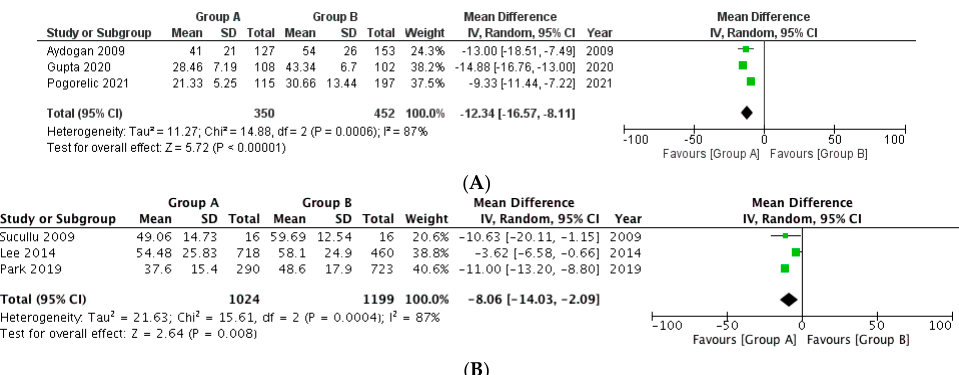
Figure 4. Forest plot comparison between the two patient groups (group A included cases where energy device was used while group B included patients in whom suture or Endoclip or Hem-o- lok ® was used) in terms of the average operative time (minutes). Figure 4A, B depict the outcome comparison with respect to appendicular base ligation and mesoappendix division, respectively.